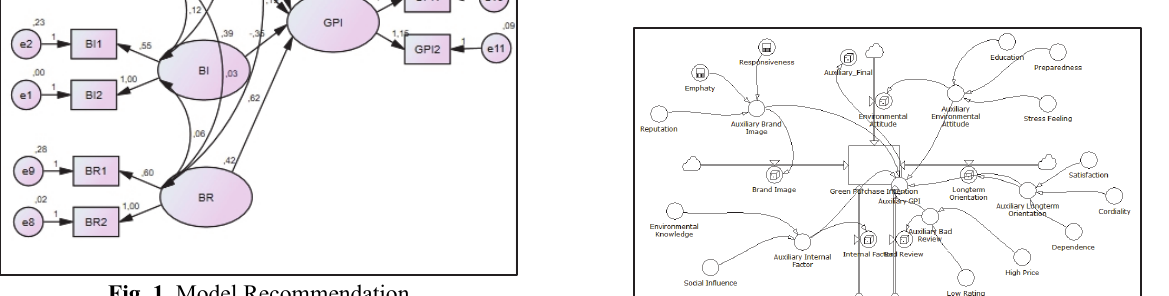
Fig. 2. Causal Loop Diagram for simulation